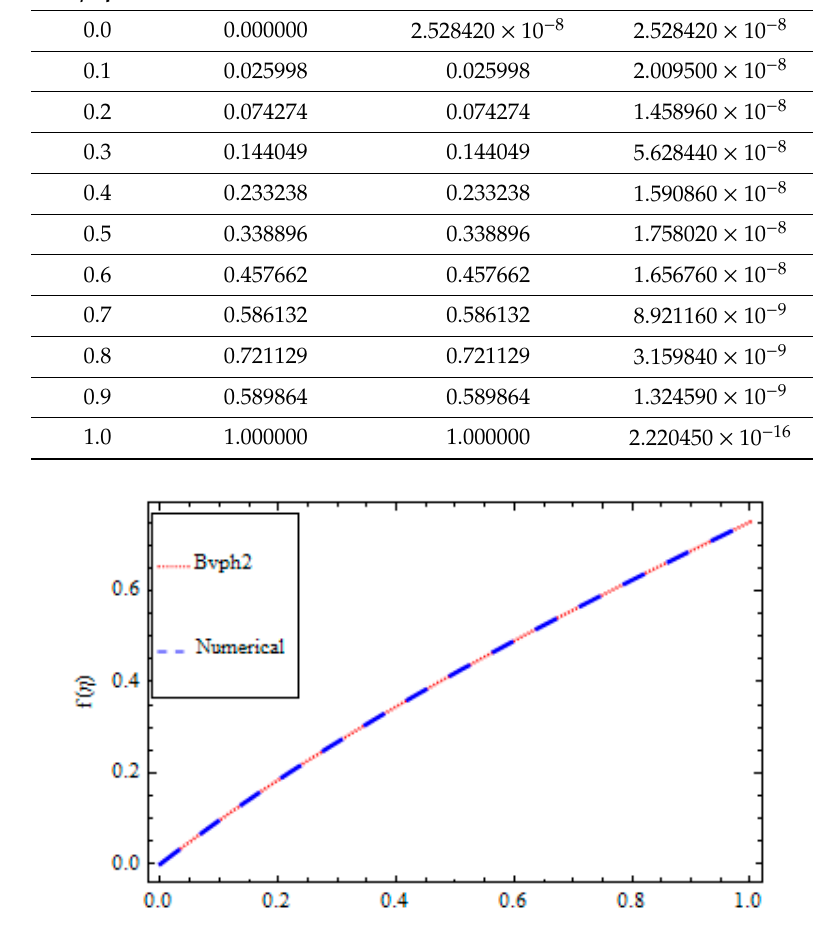
Figure 2. Graphical comparison of the HAM and numerical solution. Processes 2019 , 7 , x FOR PEER REVIEW Table 2. Comparisons of the HAM and numerical solution.